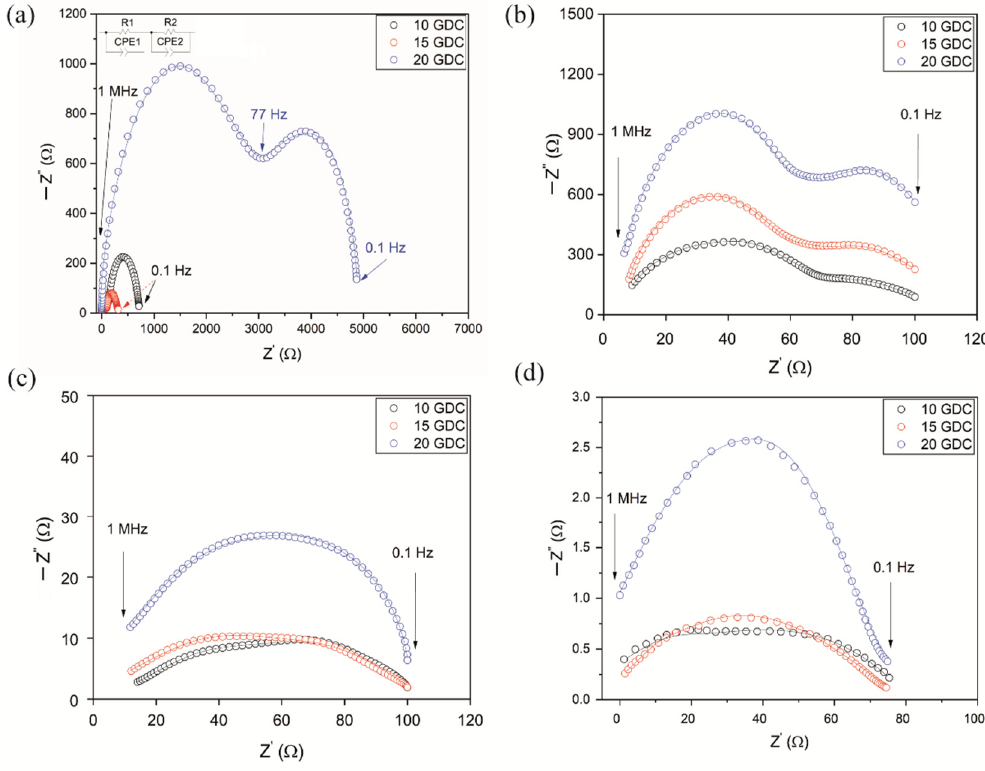
Figure 4. Complex impedance plots at: ( a ) 250 °C, ( b ) 400 °C, ( c ) 600 °C, and ( d ) 800 °C of the different compositions of GDC pellets annealed at 1200 °C. An example of an equivalent circuit, where CPE is the constant phase element, and R is the resistance for bulk, grain boundary, and electrode has been inserted in the top left-hand corner of ( a ).